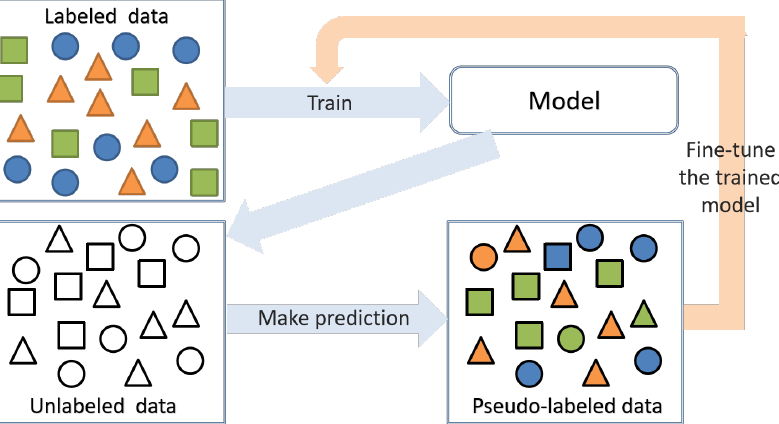
Figure 5. The illustration of the self-training method. The model trained by the labeled data is fine-tuned by the pseudo-labeled data selected from the unlabeled